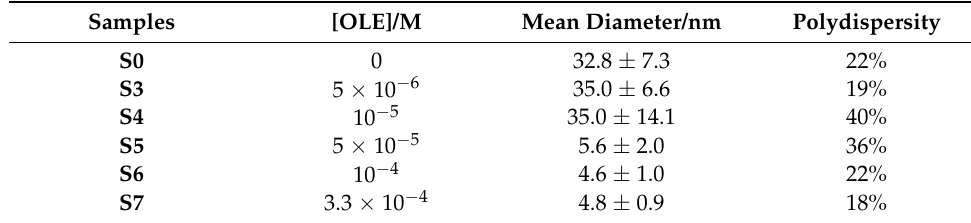
Figure 7. Higher magnification images of samples ( a ) S7, ( b ) S6, and ( c ) S5, showing morphology details. Scale bar corresponds to 20 nm in all cases. Table 3. Mean particle size of samples S0 and S3 to